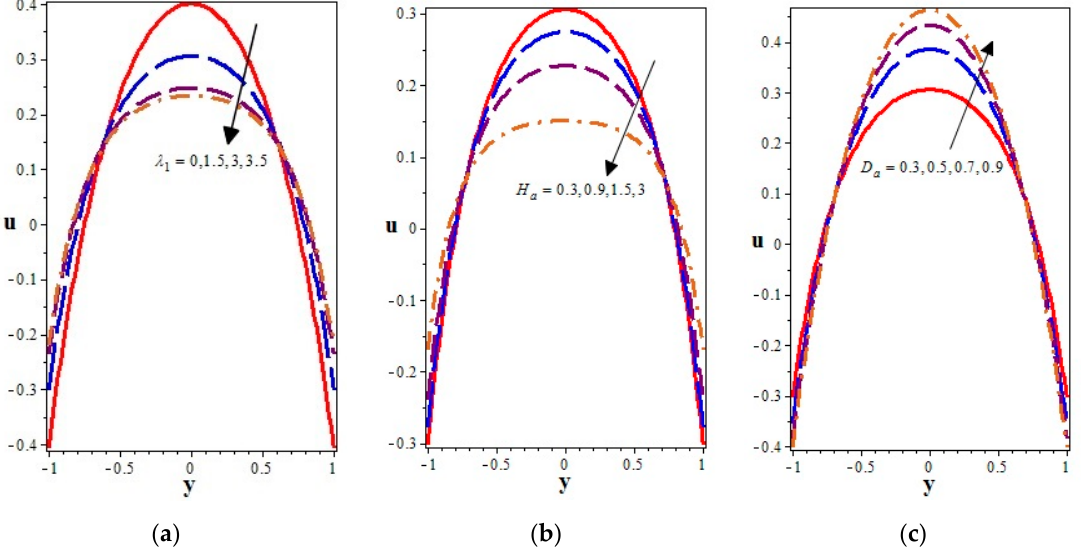
Figure 2. Axial velocity profiles for: ( a ) λ 1 when H a = 0.3, D a = 0.3, ( b ) H a when λ 1 = 1.5, D a = 0.3, and ( c ) D a when H a = 0.3, λ 1 = 1.5. Other parameters were fixed as g t = 0.5, S t = 0.5, M = 0.1, g c = 0.5, S r = 0.5, S c = 0.1, Q = 0.9, β = 0.4, ε = 0.3, and δ = 0.3 at x = 1.